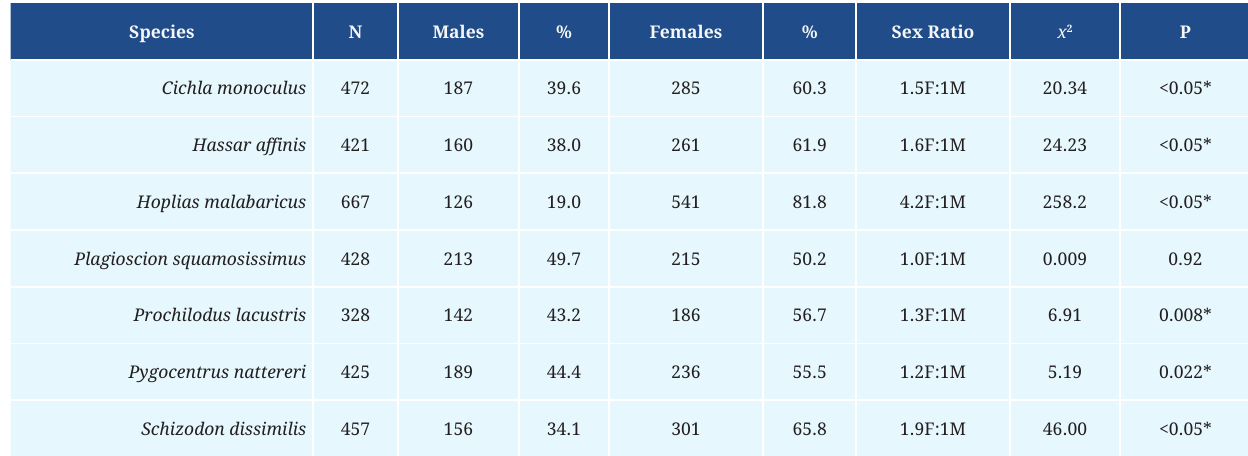
TABLE 2 | Sex ratio between males and females by species caught in Baixada Maranhense Protection Area, Legal Amazon, between January 2012 and December 2016. Asterisks indicate statistical significance in sex ratio, as determined by Chi-square test (p <